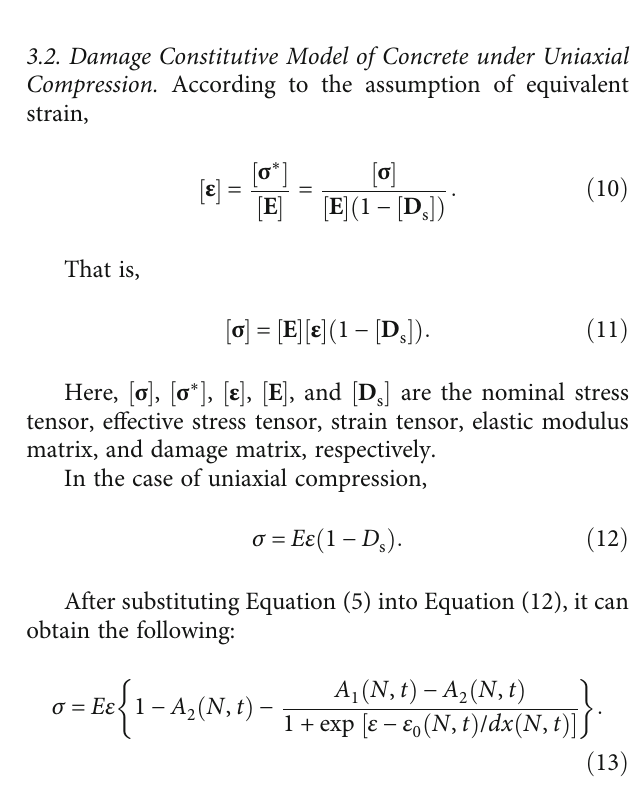
Figure 5: Experimental and theoretical curves of stress-strain of concrete with composite admixture under 30 (a), 110 (b), 190 (c), and 270 (d) days of corrosion after 90 freeze-thaw cycles.